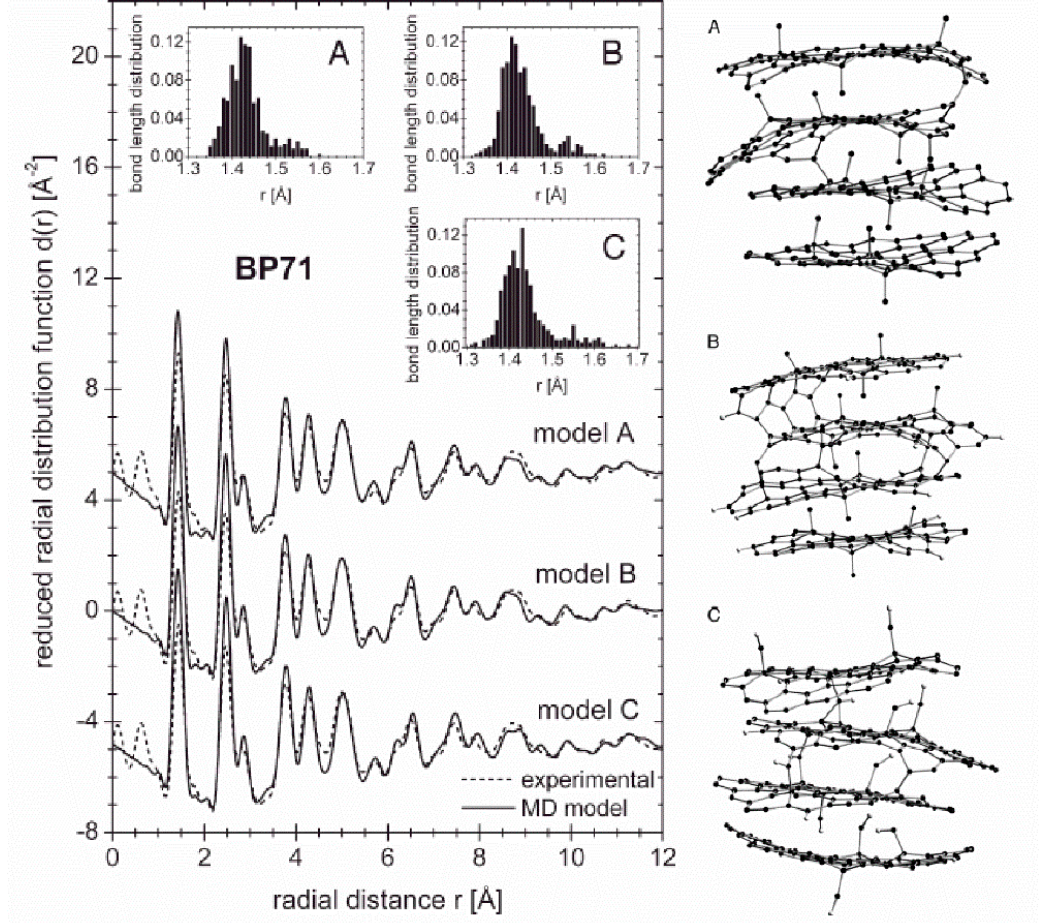
Figure 22. Comparison of the simulated and experimental pair distribution functions for commercial activated carbon BP71 ( left ). Visualisation of optimized models for the average structural unit of BP71 carbon ( right ). Reproduced with permission from Hawelek et al. [25]. Copyright International Union of Crystallography, 1997.